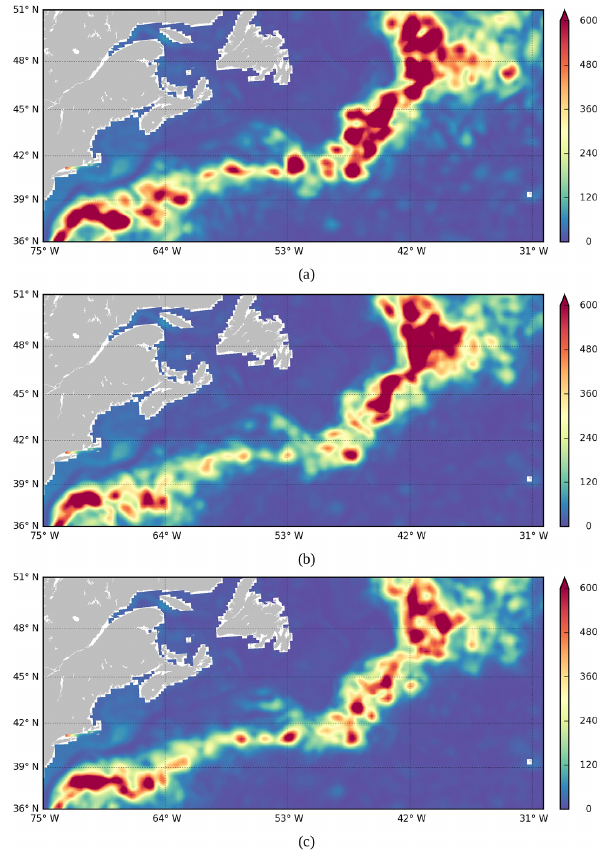
Figure 4. GS 7-day forecast MSE of SL in cm 2 for Sat1 (a) , Sat2 (b) and Sat3 (c) .